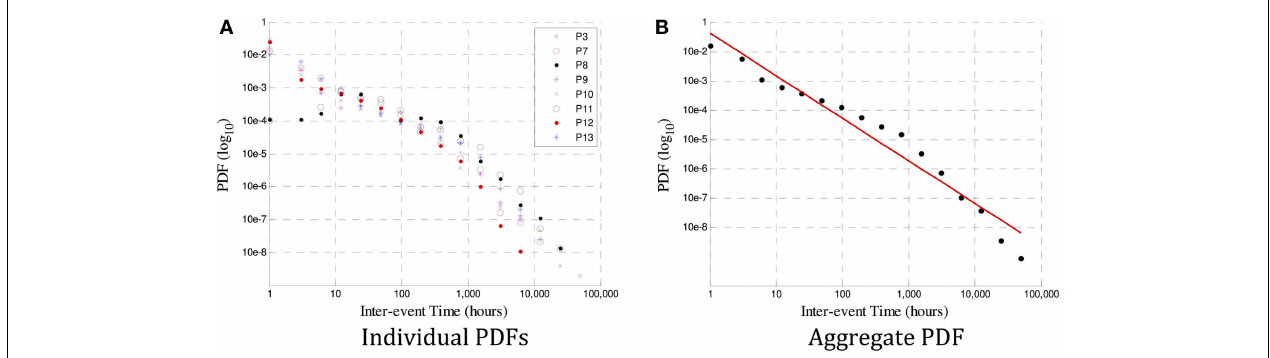
gradient β =− 1.5.The deviation from linearity that occurs at ~1000h is also observed at a different time in ~10% of the subjects in Ref. (18), and could be caused by insufficient data at large time scales (leading to an under-estimate of β ) or by a genuine excursion from a true power law in the